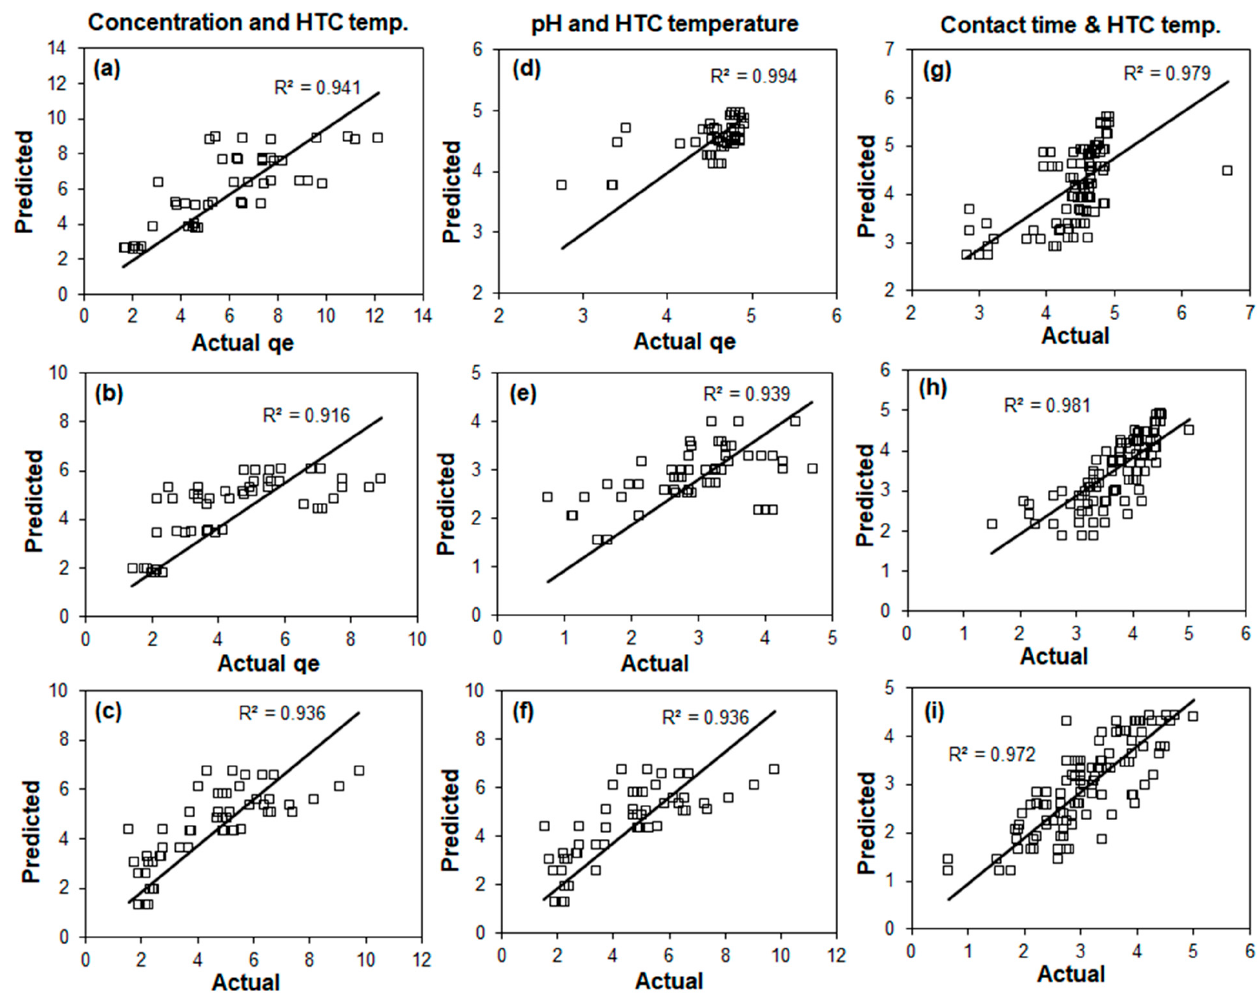
Figure 7. Predicted vs. actual results of adsorption capacity for: concentration and HTC temperature modelling; ( a ) FS hydrochars, ( b ) CS hydrochars, ( c ) Oak hydrochars. pH and HTC temperature modelling; ( d ) FS hydrochars, ( e ) CS hydrochars, ( f ) Oak hydrochars. Contact time and HTC temperature modelling; ( g ) FS hydrochars, ( h ) CS hydrochars, ( i ) Oak hydrochars.